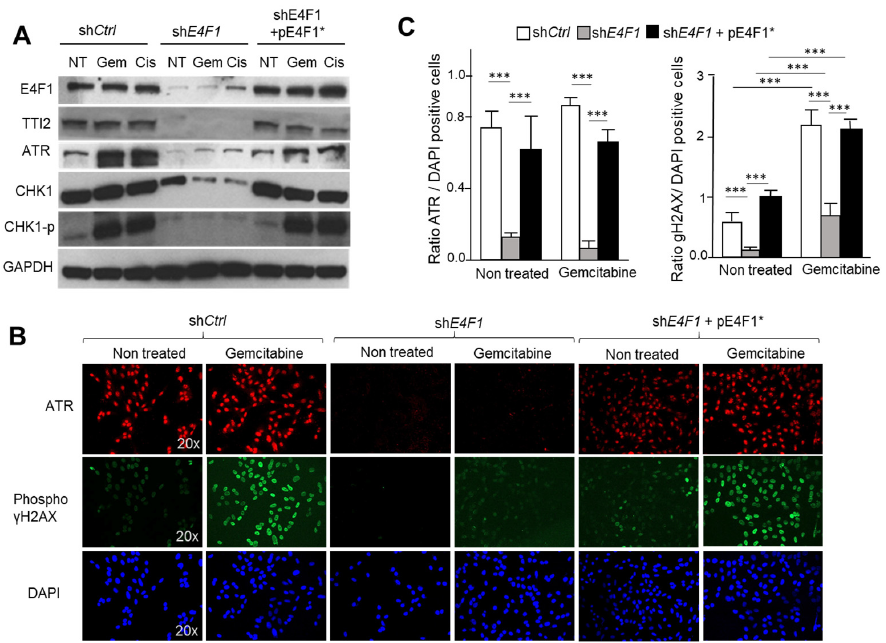
Figure 5. E4F1-depletion impacts on ATM/ATR-CHK1 signaling in response to CT drugs Gemcitabine and Cisplatin. ( A )—ShRNA-mediated depletion of E4F1 in SUM159 TNBC cells impacts on CHK1 protein level and on the S 345 phosphorylation of CHK1 by ATM/ATR in response to Gemcitabine and Cisplatin. This effect was reversed by the co-expression of the shRNA resistant pE4F1* cDNA. Immunoblot analysis of indicated proteins or phosphor-proteins (CHK1 P ) in total extracts prepared from SUM159 cells transduced with either control shRNA (sh Ctrl ), sh E4F1 , or sh E4F1 + pE4F1*, and treated for 24 h with Gemcitabine or Cisplatin. See also immunoblots in Figure S3B (Supplementary Materials) showing a similar experiment in another TNBC cell line, HCC38; ( B , C ) Immunofluorescence staining of DNA (blue), phospho (S139)- γ H2AX (green) and ATR (red) in SUM159 cells transduced with either sh Ctrl , sh E4F1 , or sh E4F1 + pE4F1*, and upon antibiotics selection, treated for 24 h with Gemcitabine; ( B ) Representative experiment; ( C ) Quantitation of three independent experiments expressed as mean values ± SD. *** p < 0.001 as determined by two-tailed unpaired t -test performed on Graph Pad Prism. See also Figure S4 (Supplementary Materials) for immunoblotting analysis of γ H2AX phosphorylation in cell lysates.